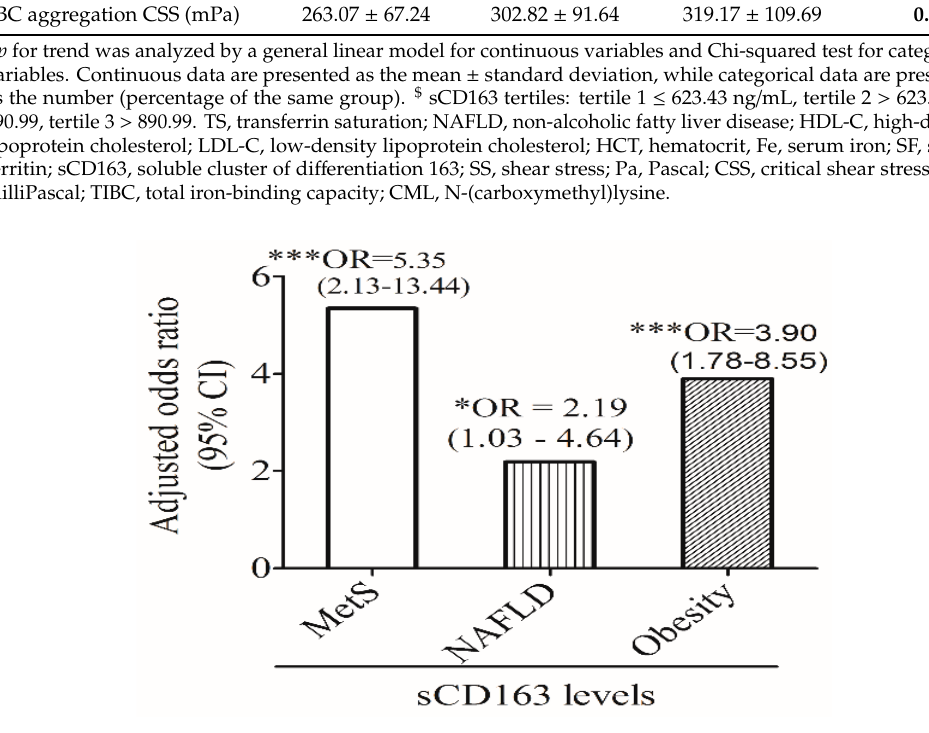
Figure 2. Age- and sex-adjusted odds ratios (ORs) and 95% confidence intervals (CIs) of soluble (s) CD163 levels for metabolic syndrome (MetS), non-alcoholic fatty liver disease (NAFLD), and central obesity. * p ≤ 0.05, *** p ≤ 0.001.